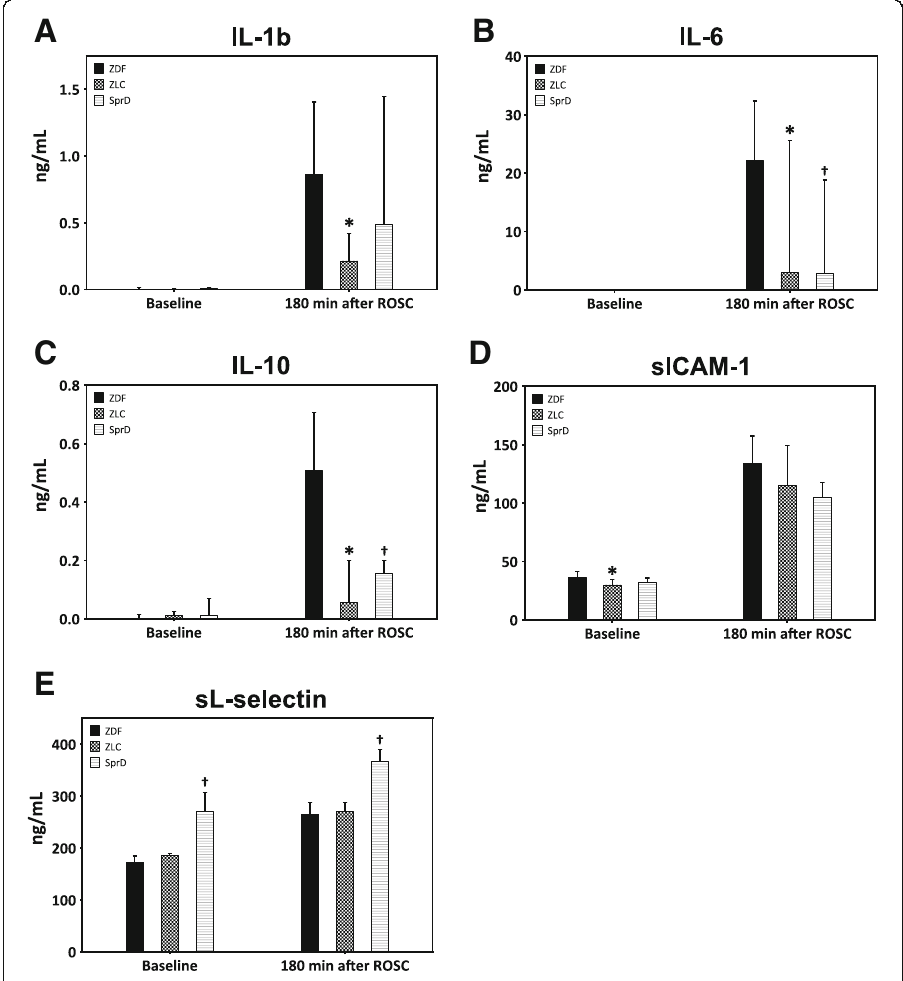
Fig. 5 Cytokine and soluble endothelial adhesion molecules. Data are presented as median and associated quartiles (Q 25 and Q 75 ). a IL-1b. b IL-6. c IL-10. d Soluble ICAM-1. e Soluble L-selectin. Number of animals: ZDF ( n = 11, one missing data point at 180 min after ROSC), ZLC ( n = 6), and SprD ( n = 8). For all analyses, only the animals achieving ROSC are included. * p < 0.05 ZDF vs. ZLC; † p < 0.05 ZDF vs. SprD. ROSC: return of spontaneous circulation, ZDF: Zucker diabetic fatty group, ZLC: Zucker lean control group, SprD: Sprague Dawley